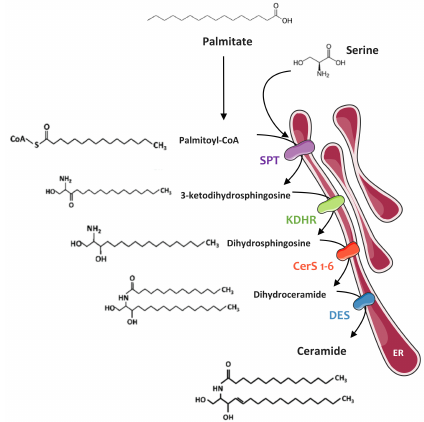
Figure 1. Ceramide de novo synthesis pathway. Palmitate is the preferential fatty acid used for the de novo synthesis of ceramides. The biosynthesis pathway takes place in the ER. Palmitoyl-CoA is first condensed with a serine to form a 3-ketodihydrosphingosine through the action of SPT. 3-Ketodihydrosphingosine is rapidly metabolized into dihydrosphingosine by KDHR. Formed dihydrosphingosine are acylated by different isoforms of CerS to form dihydroceramides of different chain lengths. Dihydroceramides are then desaturated by DES1 to give ceramides. ER: Endoplasmic reticulum; SPT: Serine palmitoyl transferase; KDHR: 3-ketodihydrosphingosine reductase; CerS: Ceramides synthases; DES1: Dihydroceramide ∆